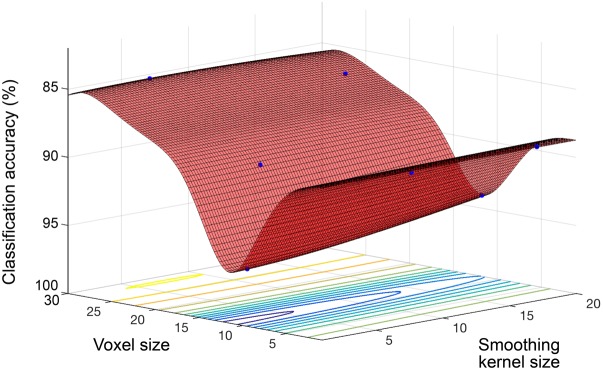
Objective function model for classification of young and old. Objective function model showing the space of voxel size and smoothing kernel values in terms of old versus young classification performance with a linear kernel SVM. The red surface is the function model and represents performance at each location. Points where the parameter space was sampled are shown (blue).